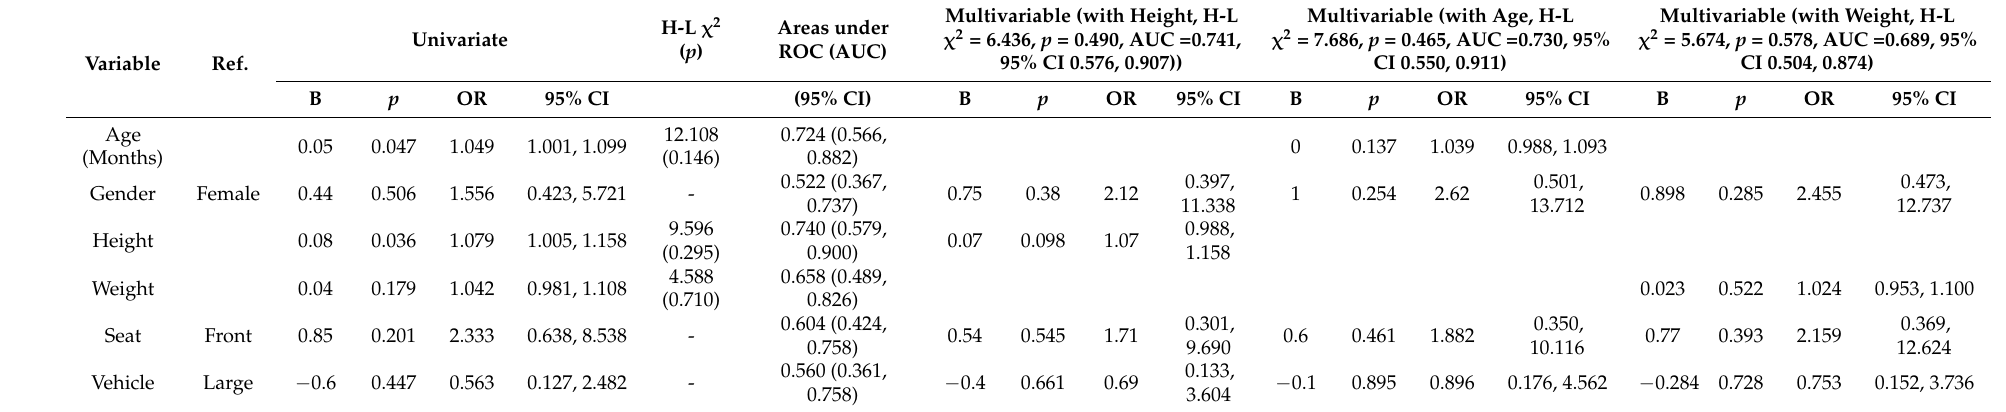
Table 3. Regression results for overall seat belt